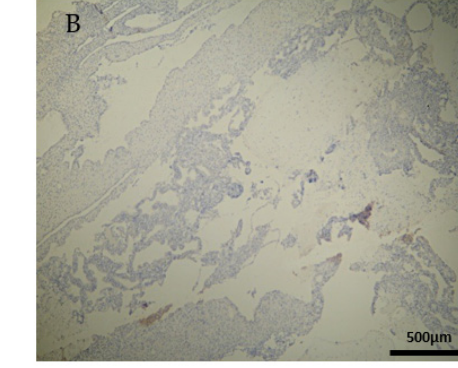
Figure 7 . Evaluation of positive CD20 antigen expression. Miscarriage experimental group (EG): ( Α ) Moderate CD20 intensity of staining in the DP (4 × 10 magnification). ( Β ) Negative expression of CD20 in the DB (4 × 10 magnification).